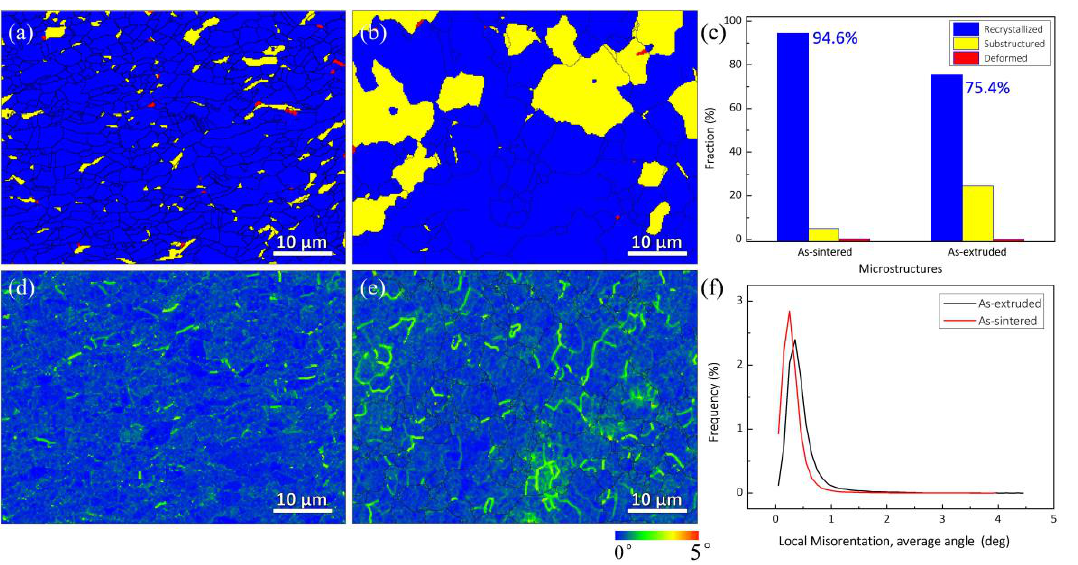
Figure 3. Recrystallized, substructured, and deformed grains in ( a ) as-sintered and ( b ) as-extruded composites, ( c ) statistics of grains in ( a , b ). KAM maps of ( d ) as-sintered and ( e ) as-extruded composites, ( f ) KAM values, corresponding to ( d , e ).